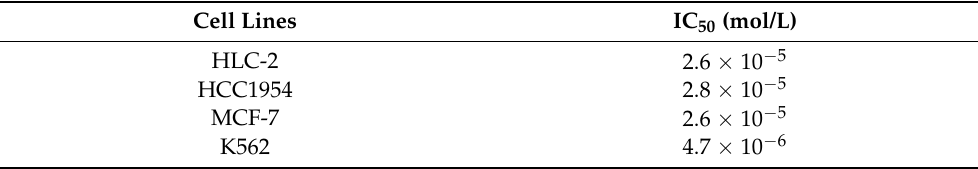
Table 4. Effect on Bone Resorption Activity of Osteoclast. Figure 5. BP ‐ conjugate 29 . Figure 5. BP ‐ conjugate 29 .